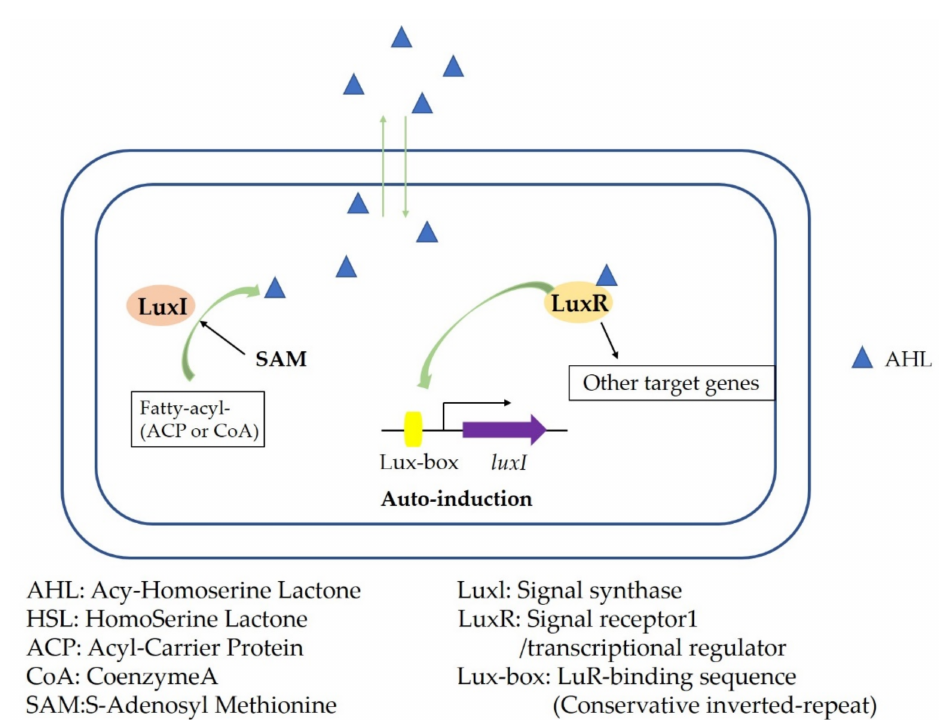
Figure 3. Acyl-homoserine lactone (AHL) quorum-sensing